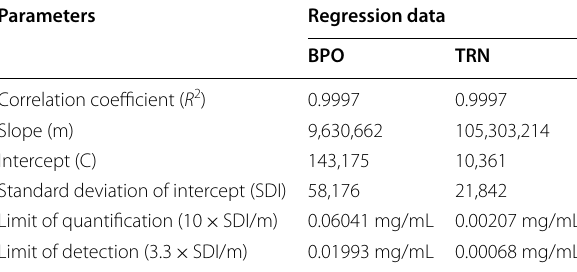
Table 3 Regression data